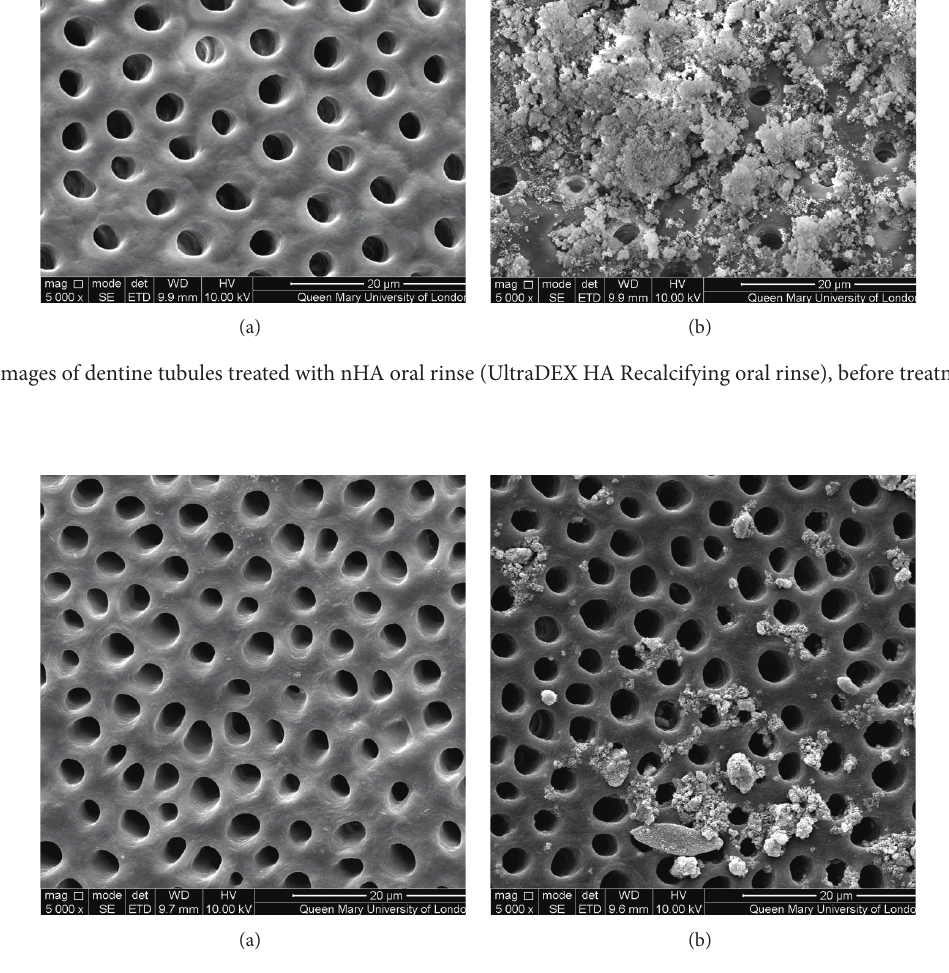
Figure 2: SEM images of dentine tubules treated with a zinc substituted HA oral rinse (Biorepair MicroRepair Mouthwash), before treatment (a) and after treatment